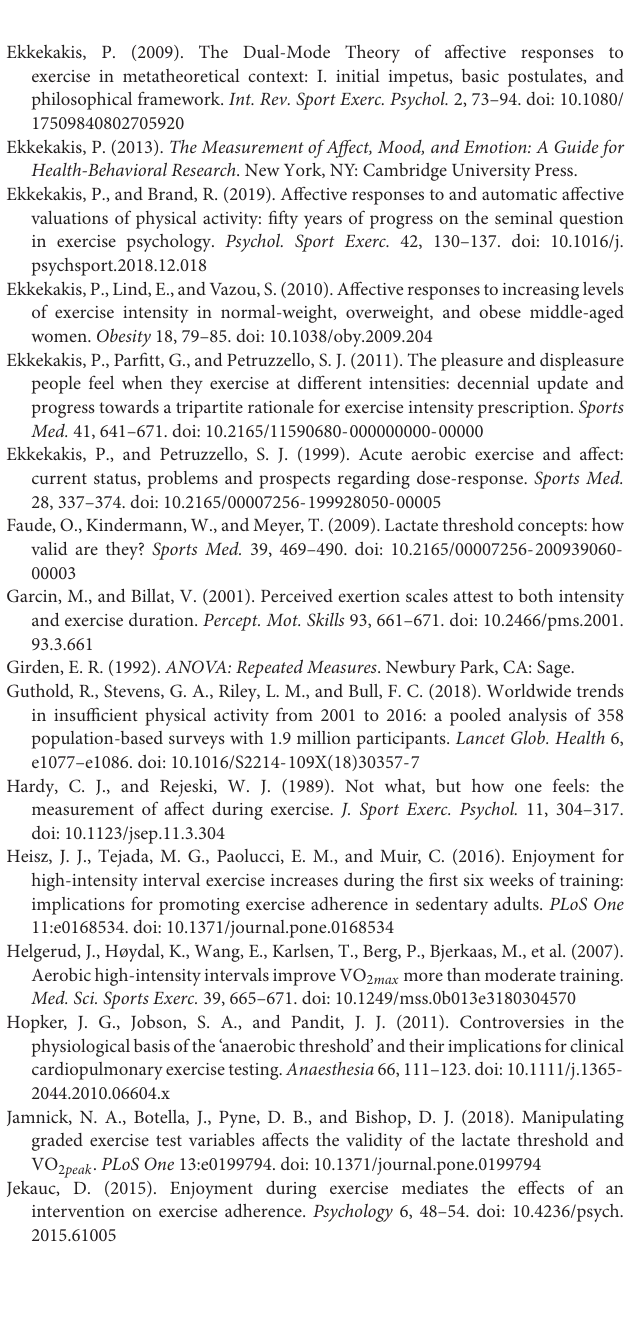
Supplementary Table 2 | Translated version of Feeling Scale (FS) and translated version of Exercise Enjoyment Scale (EES). Supplementary File 1 | The dataset for this